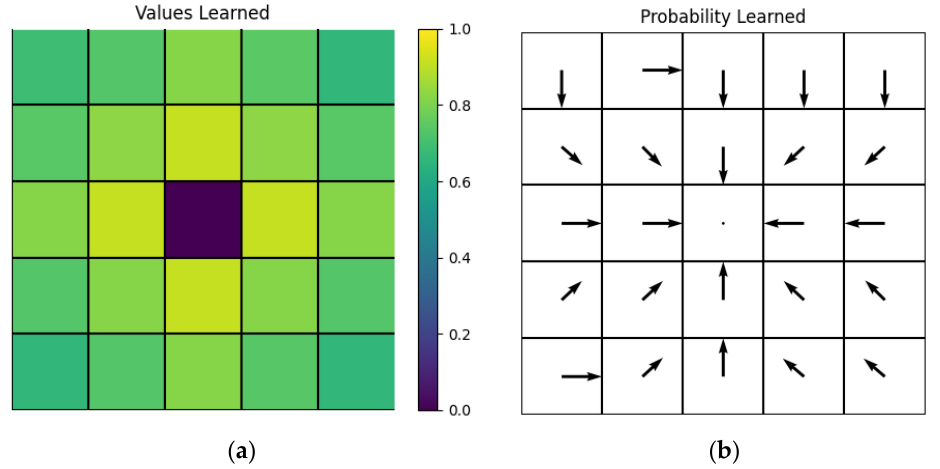
Figure 9. The results of actor-critic learning while the destination is the state in the center: ( a ) The values’ color map learned by critic, σ V = 0.01172; ( b ) The probability arrow map learned by actor.